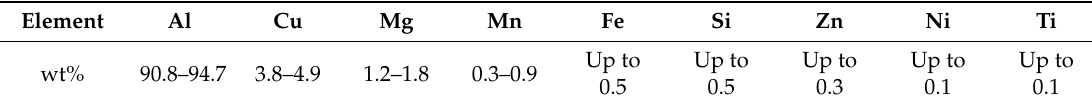
Table 4. Chemical composition of D16 alloy (AA2024, AlCuMg2) in